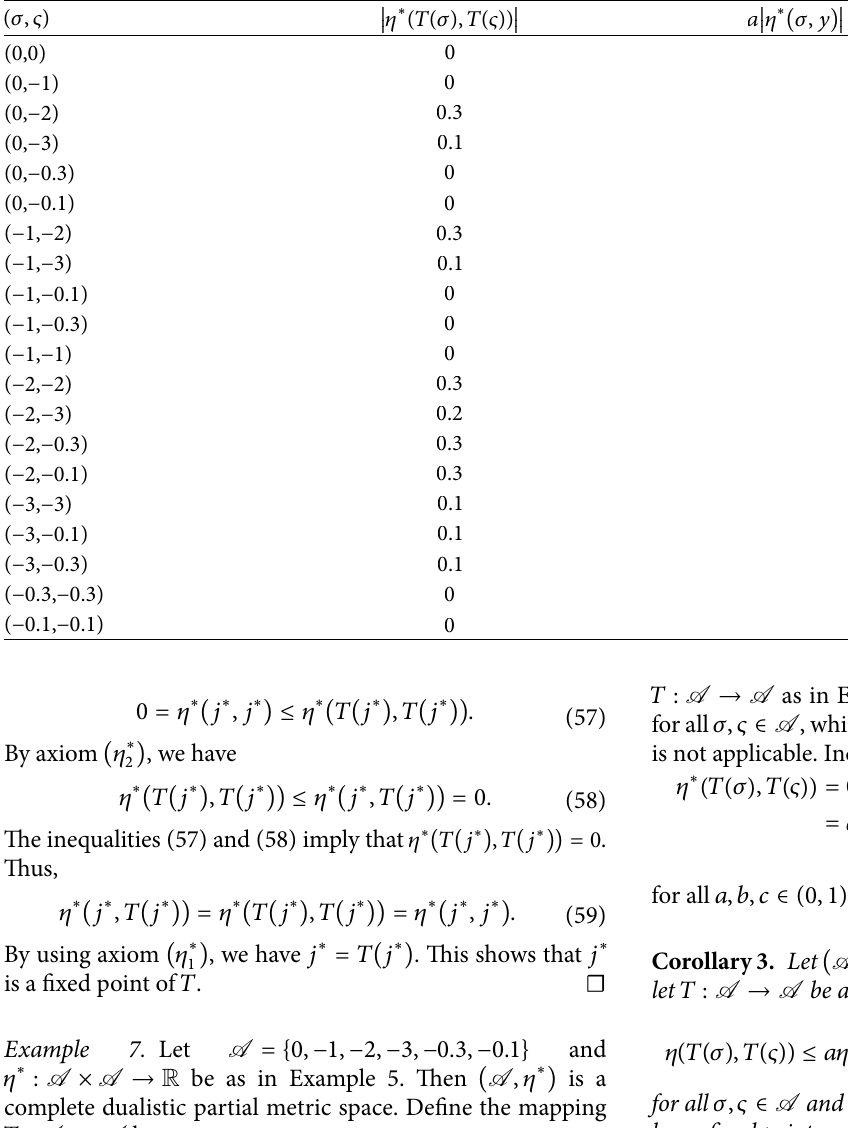
Table 1: Evaluation of contractive